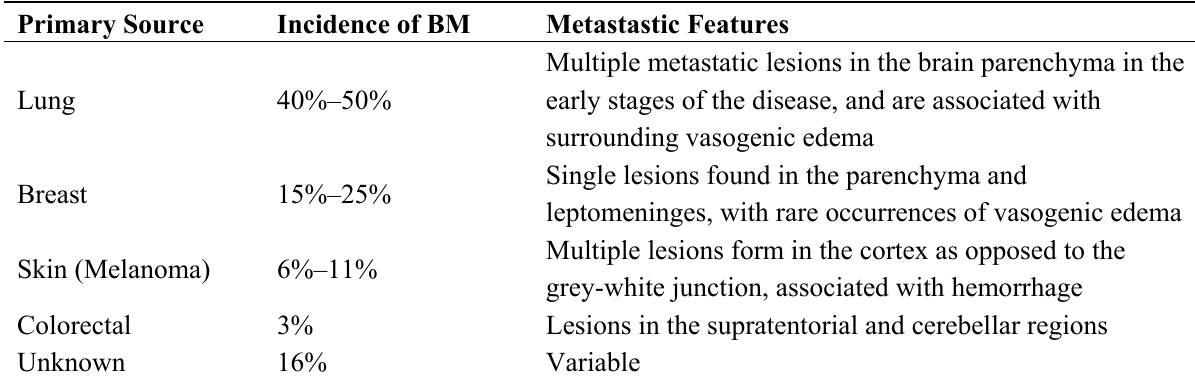
Table 1. Common primary organ sources of brain metastasis.